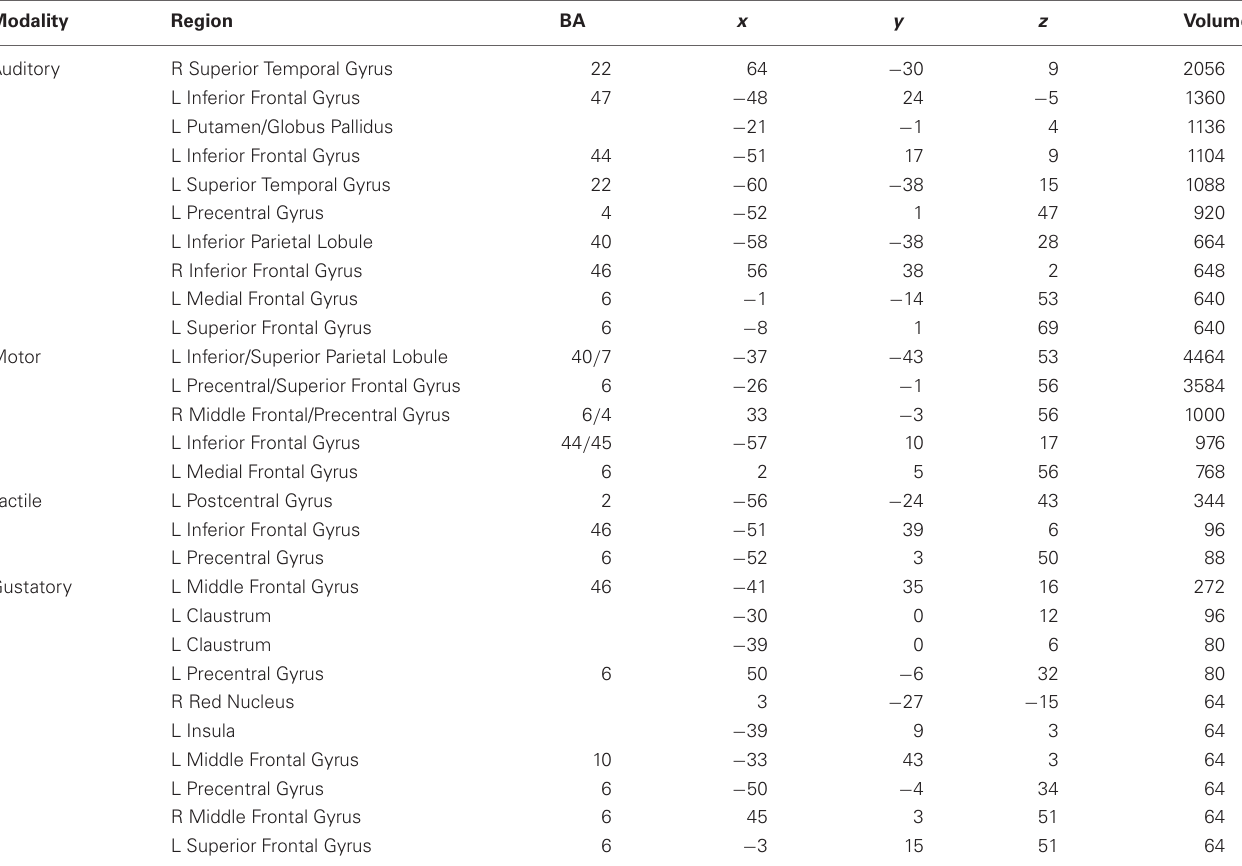
Table 3 | Weighted centers of significant clusters in the auditory, motor, tactile, and gustatory imagery ALE analyses. Modality